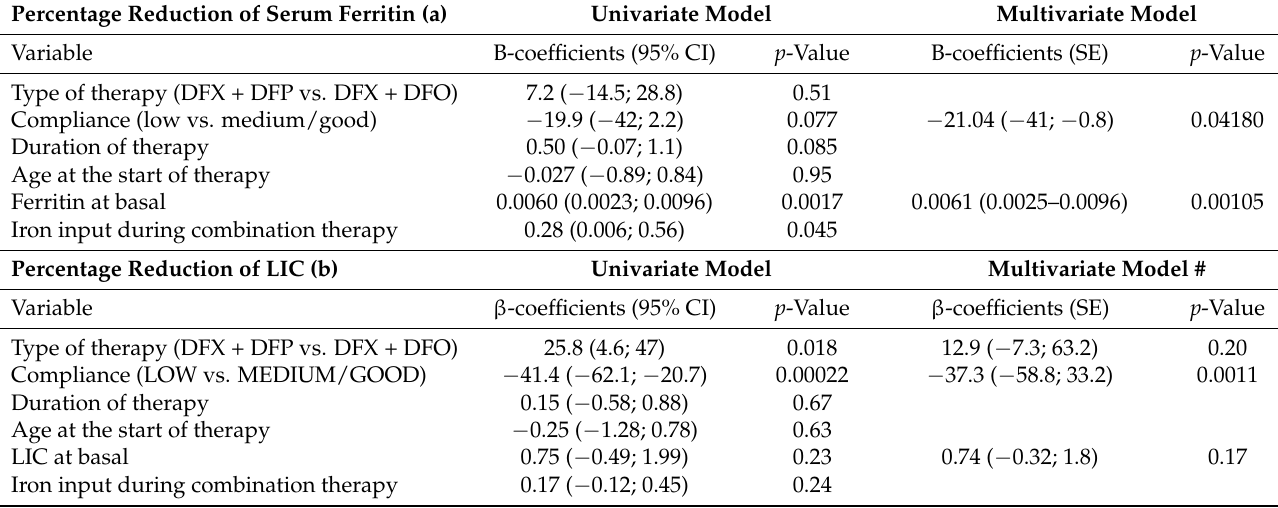
Table 2. Univariate and multivariate analysis of the association between type and duration of therapy, demographic factors, iron status, and compliance with the percentage reduction of serum ferritin (a) and LIC